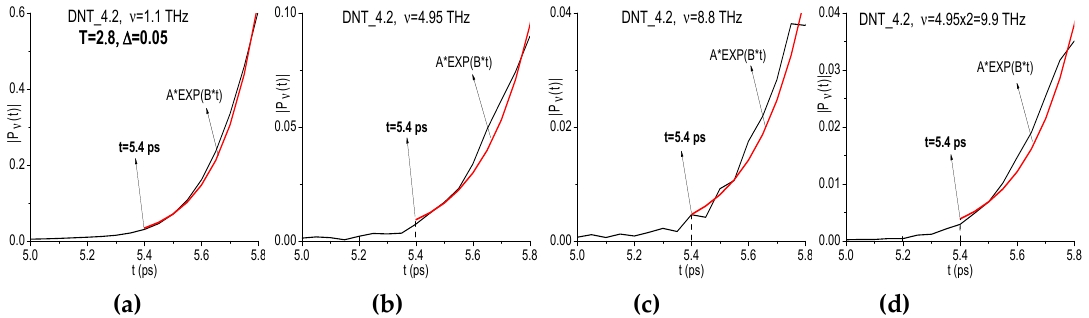
Figure 11. Evolution of the spectral amplitude modulus at the frequencies ν = 1.1 THz ( a ), 4.95 THz ( b ), 8.8 THz ( c ), 9.9 THz ( d ) in the time interval t = [5.0, 5.8] ps computed for the 2,4-DNT substance (black line). Red line is an approximating exponential function.